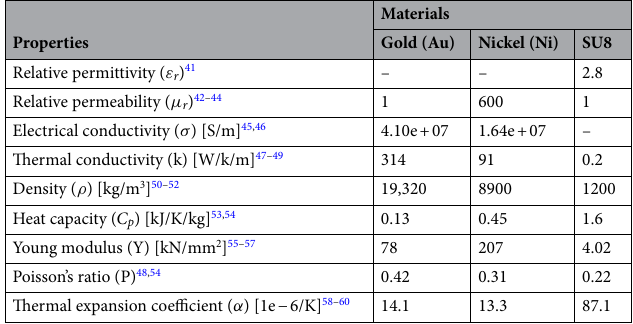
Table 1. Properties of the materials used for the numerical model.